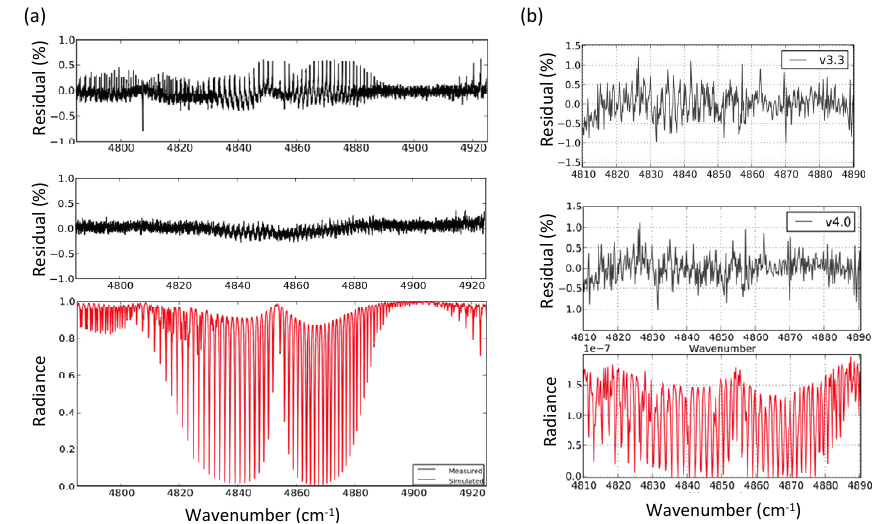
Fig. 5. (a) Spectral residuals in fits to laboratory spectra of the SCO2 band (bottom) for the absorption coefficients used here (top), and values from the more recently implemented multi-spectral fitting approach (center). (b) Same as (a) for TANSO-FTS spectra collected in the vicinity of the Lamont Oklahoma TCCON station.